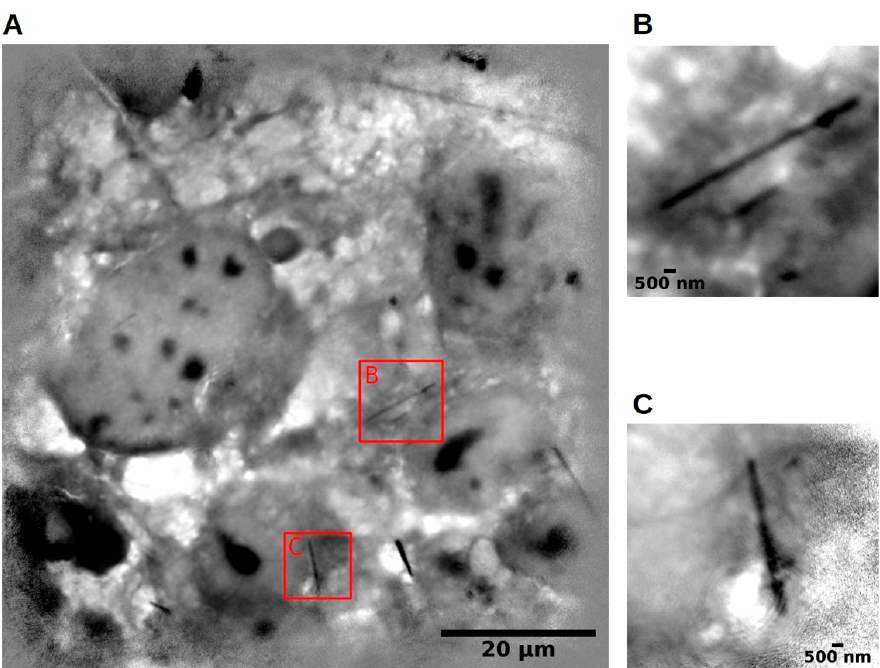
Figure 8. Panel ( A ) shows the ptychographic phase reconstruction of chemically fixed mesothelial cells. This is an example of a large field of view (>60 × 60 µm 2 ) examined with a high resolution (approx. 50 nm). Panel ( B ) and ( C ) show enlarged ROIs, as indicated in panel ( A ). The same type of scan could be subsequently performed across an energy range that covers a specific absorption edge, eventually allowing for XANES analysis.